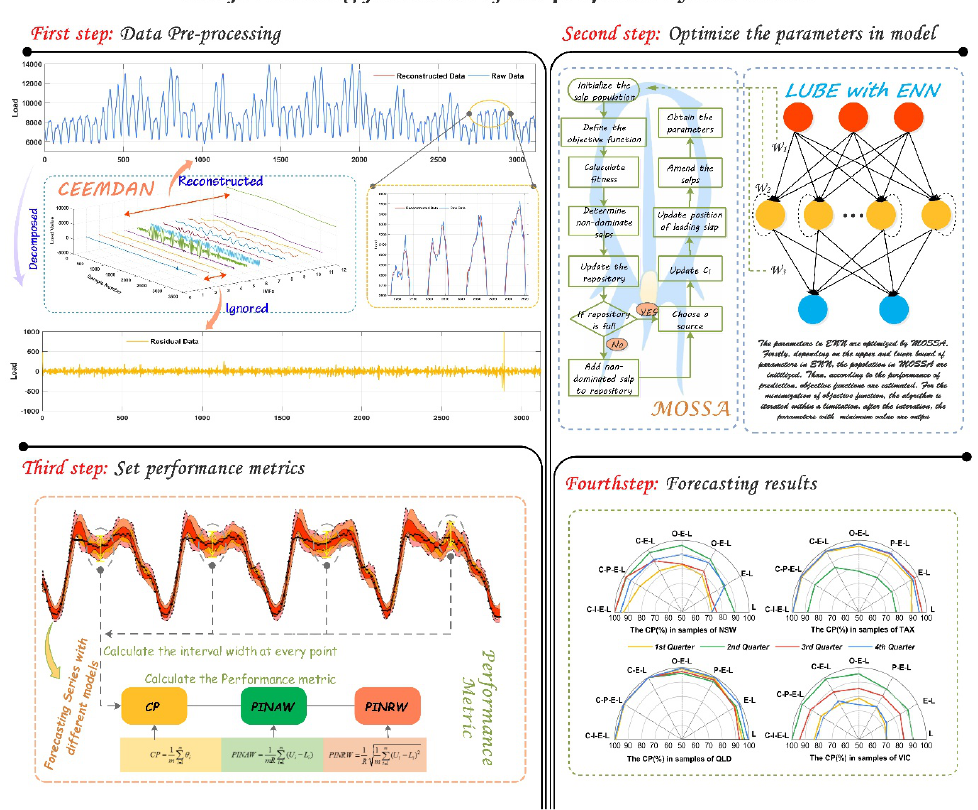
Figure 2. Forecasting flowchart of the proposed hybrid model.